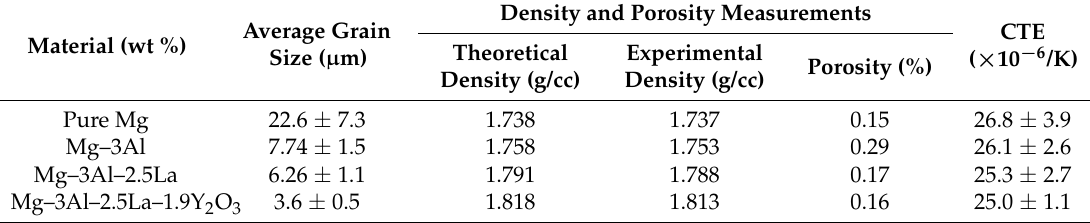
Table 1. Results of average grain size, density, porosity and Coefficient of Thermal Expansion (CTE) measurements.